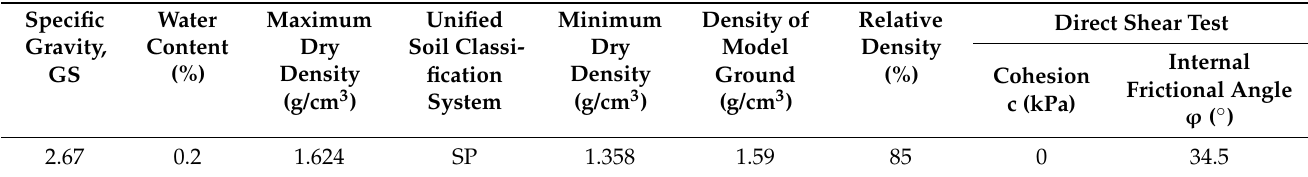
Table 2. Soil properties.